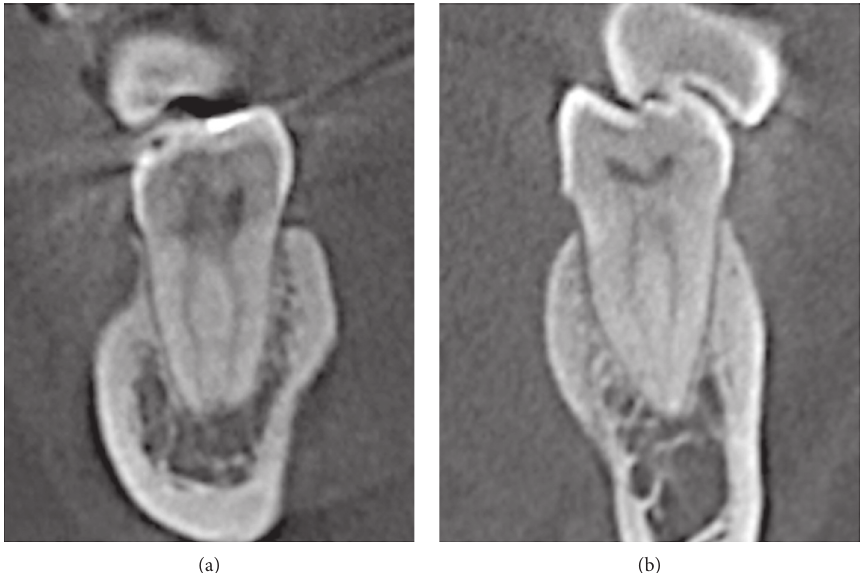
Figure 3: CBCT coronal sections. (a) Vertucci type IV canal configuration in mesial root of a mandibular first molar and (b) Vertucci type II in distal root of a mandibular first